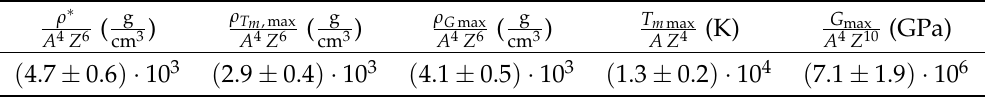
Table 1. Five parameters associated with the unified analytic melt-shear thermoelasticity model in the limit of quantum